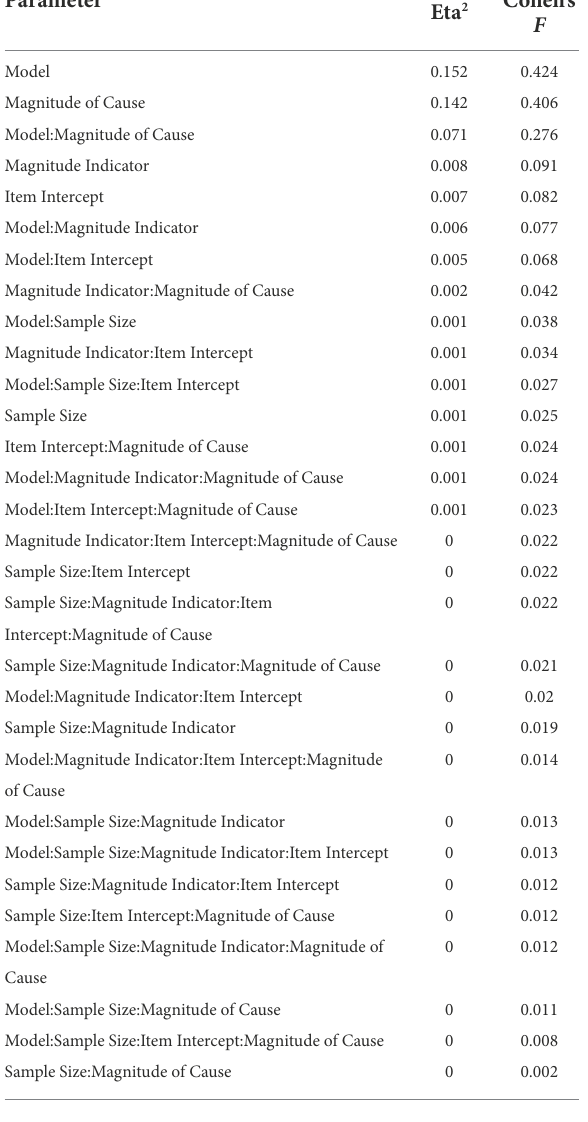
TABLE 2 ANOVA results predicting by simulation